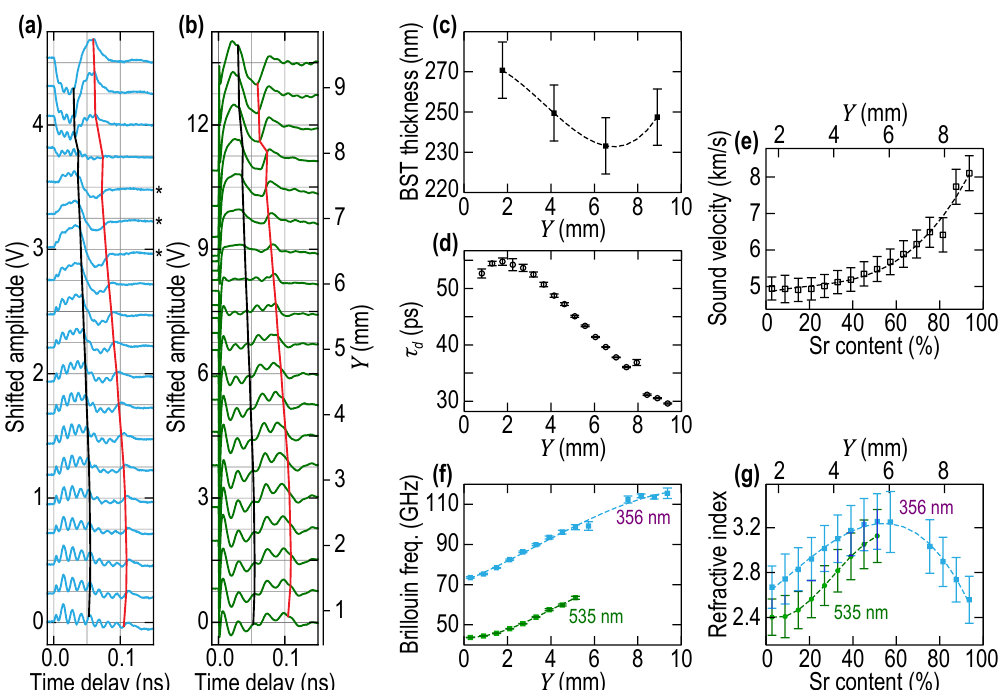
Figure 6. ( a , b ) Raw transient reflectivity signals detected at different lateral Y positions of the BSTx library using green pump and either ( a ) UV or ( b ) green probe. The black (red) solid lines connecting the raw signals vertically stand for the CAP arrival times τ d at the free surface of the BSTx library layer (at the surface between the BSTx library layer and the OAT). ( c ) BSTx library thickness as a function of the position Y along the graded direction. ( d ) Time-of-flight τ d of the acoustic wave propagating from the generator surface through the BSTx layer to its free surface estimated using the fitting procedure. ( e ) Sound velocity in the BSTx library as a function of the Sr content (bottom horizontal axis) and the position Y along the graded direction (top horizontal axis) estimated from the data in ( c , d ). ( f ) Brillouin frequencies as a function of the position Y along the graded direction of the BSTx library estimated using the fitting procedure for UV (blue experimental points) and green (green experimental points) probe. ( g ) Refractive index in the BSTx library as a function of the Sr content (bottom horizontal axis) and the position Y along the graded direction (top horizontal axis) estimated from the data in ( e , f ). The blue experimental points stand for the refractive index at the wavelength of the UV probe (356 nm), while the green ones are at the wavelength of the green probe (535 nm). Asterisks on the right of Figure 6a label the signals with the minimal interferometric and maximal photoelastic contributions, which are applied for the signal processing procedure suggested in Section